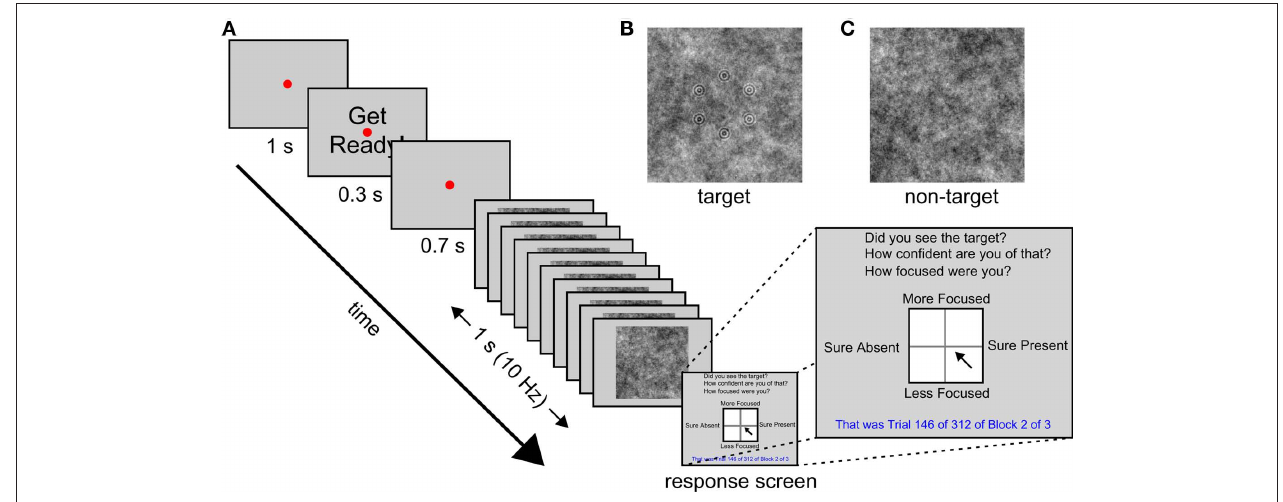
Figure 1 | Trial procedure and stimuli. (A) A schematic illustration of the sequence of events in each trial. (B) Example target image. (C) Example non-target